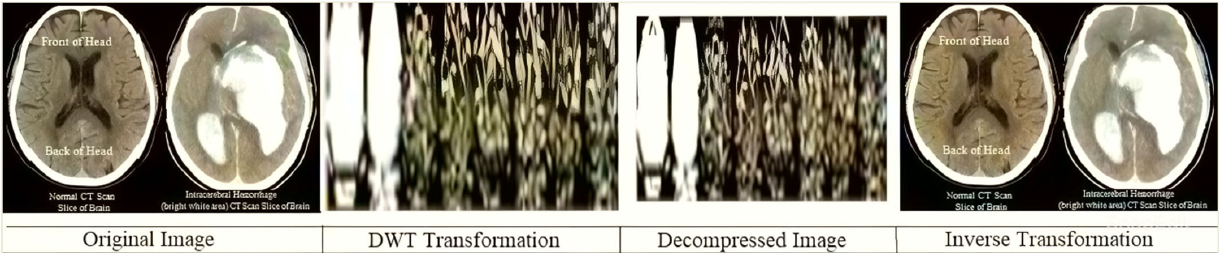
Figure 3. Hybrid transformation and compression.